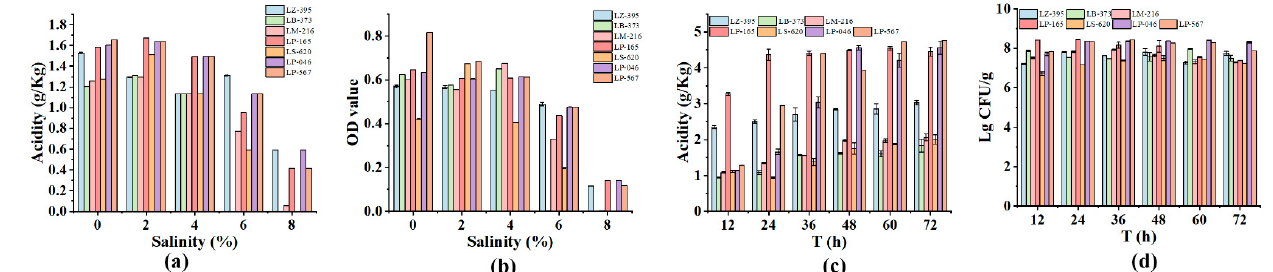
Figure 2. Screening of starter cultures. ( a , b ) Acidity and optical density (OD) values of the strain at different salt concentrations; ( c , d ) acidity and Lactobacillus number of strains at different time.